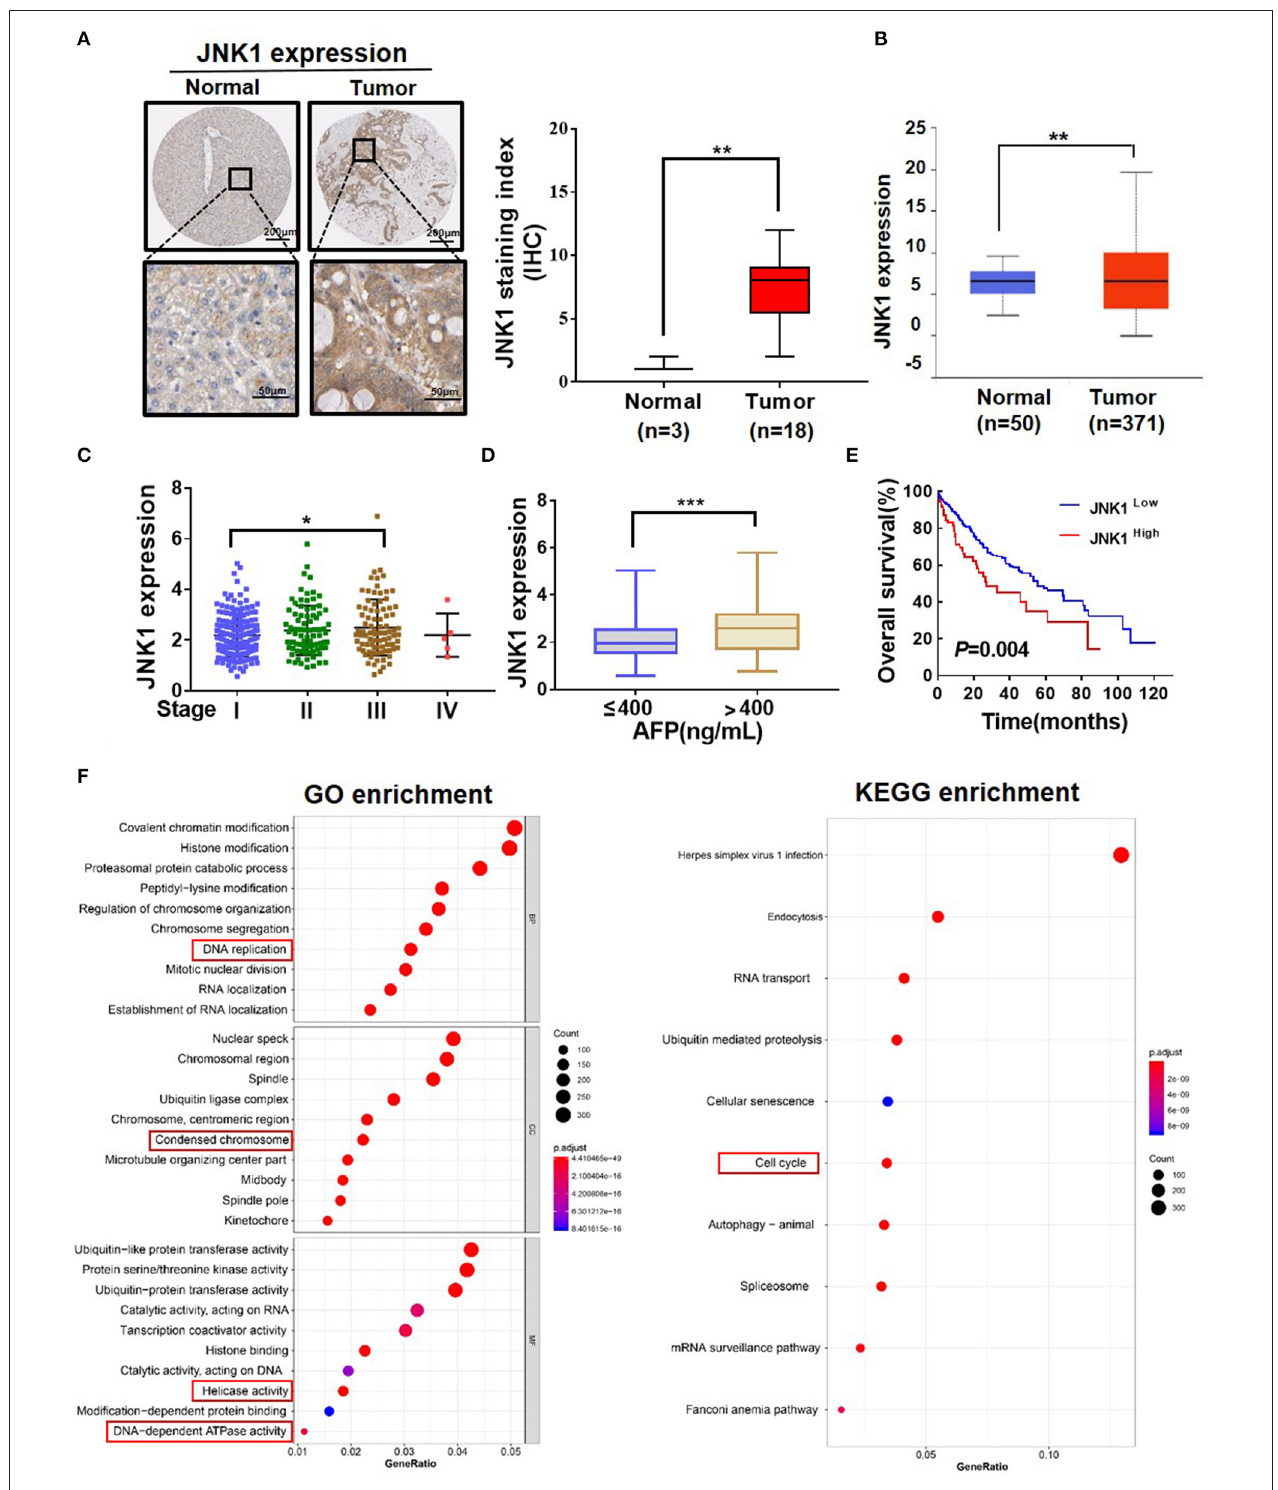
FIGURE 5 | JNK1 can aggravate the degree of malignancy of HCC. (A) Representative IHC images of JNK1 in normal tissues and tumors downloaded from the Human Protein Atlas (one-way ANOVA; ** P < 0.01). (B) Statistical analysis of JNK1 expression level in normal tissues and tumors downloaded from TCGA database (one-way ANOVA; ** P < 0.01). (C,D) Statistical analysis of JNK1 expression level in liver hepatocellular carcinoma (LIHC) based on clinical stage and AFP level (one-way ANOVA; * P < 0.05, *** P < 0.001). (E) Survival curve analysis based on low and high JNK1 expressions in LIHC samples. (F) GO and KEGG enrichment analysis of JNK1-positive